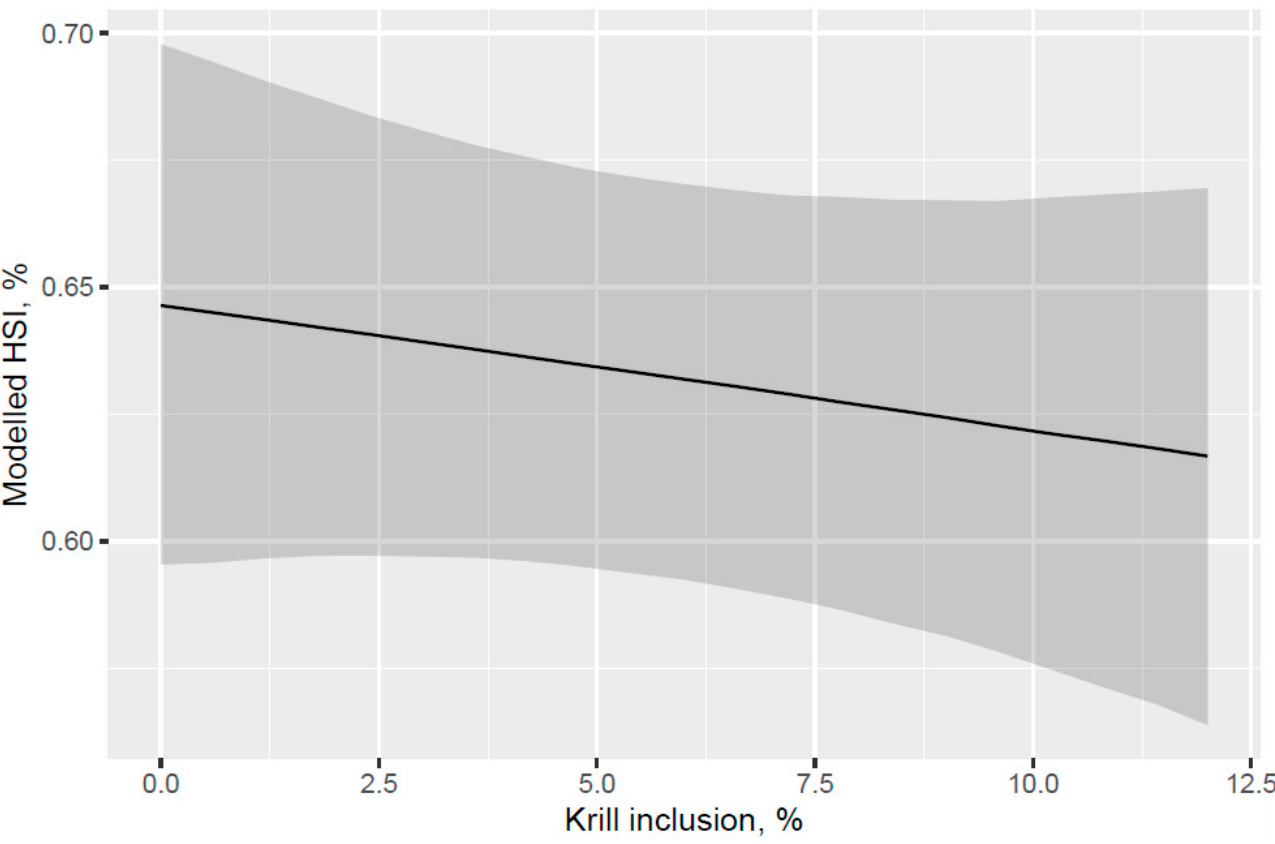
Figure 7. Modelled hepatosomatic index (HSI) with increasing KM inclusion after 53 d of feeding in the freshwater pre-transfer phase plotted with 95% credible intervals as the grey band. HSI is derived from the model for a 160 g average-sized sampled fish.